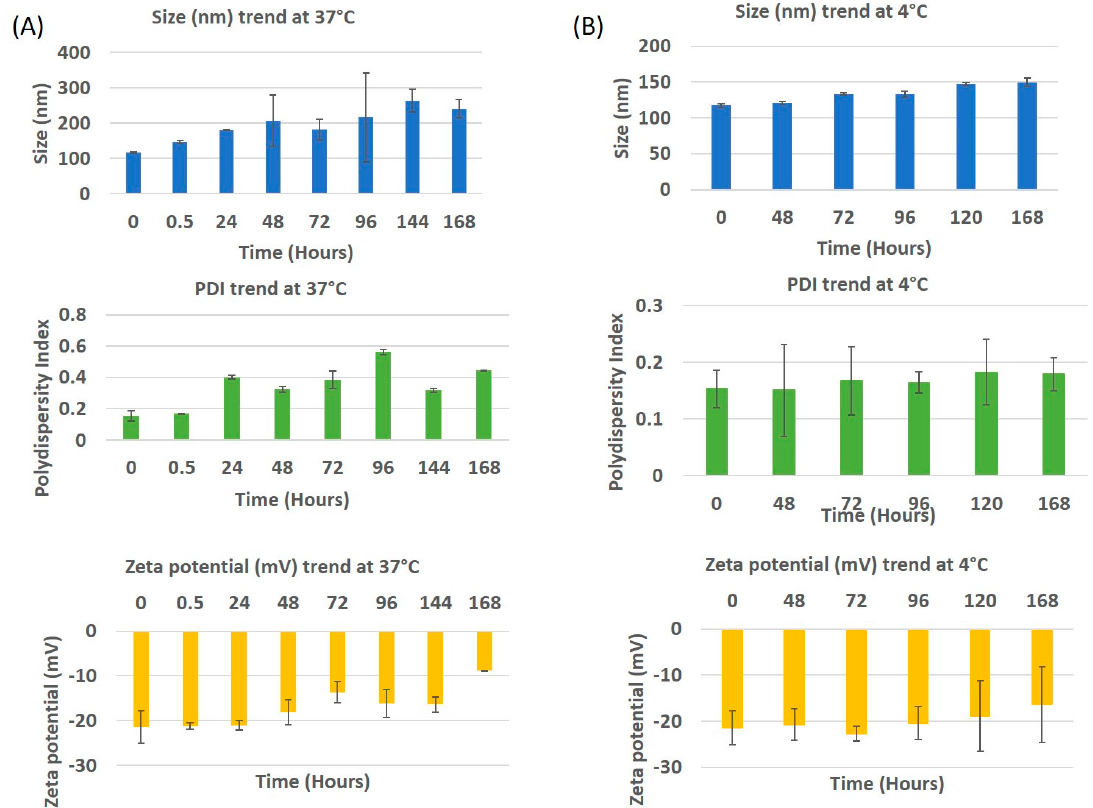
Figure 3. In vitro stability of drug encapsulated PLGA-PEG nanoparticles in media at ( A ) 37 °C and ( B ) 4 °C. The trends of size, PDI and zeta potential are indicated.